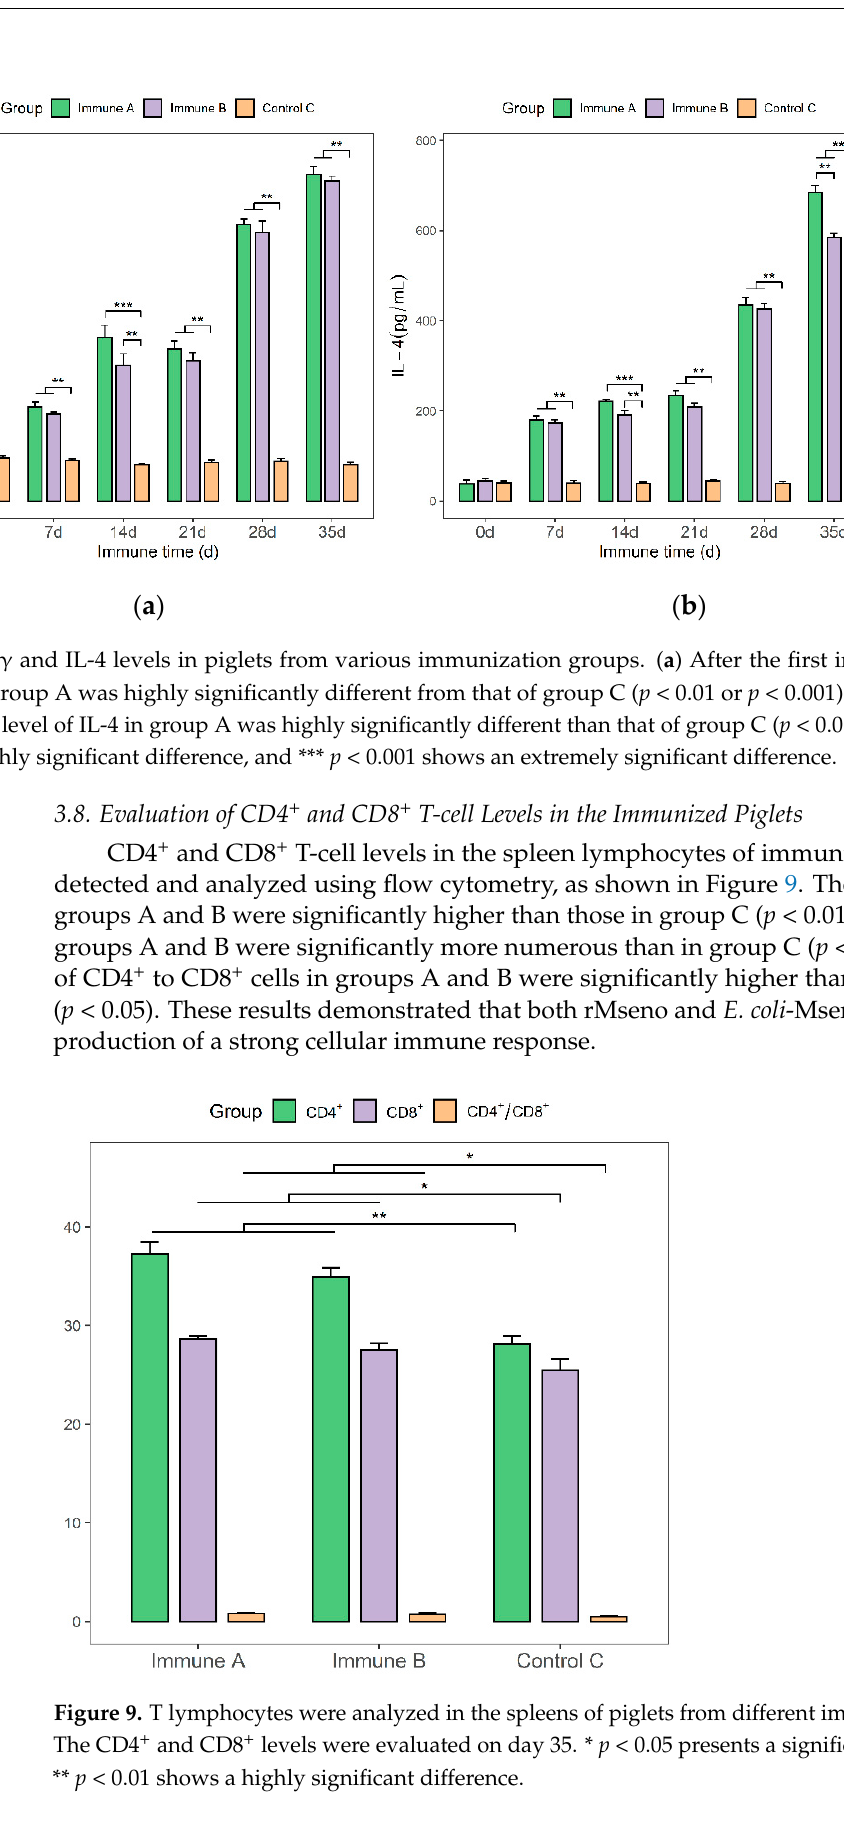
Figure 9. T lymphocytes were analyzed in the spleens of piglets from different immunization groups. The CD4 + and CD8 + levels were evaluated on day 35. * p < 0.05 presents a significant differ- ence, and ** p < 0.01 shows a highly significant difference.